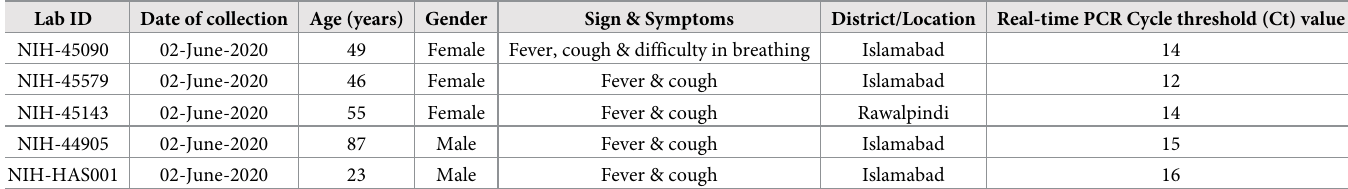
Table 1. Clinical and demographic details of SARS-CoV-2 patients.